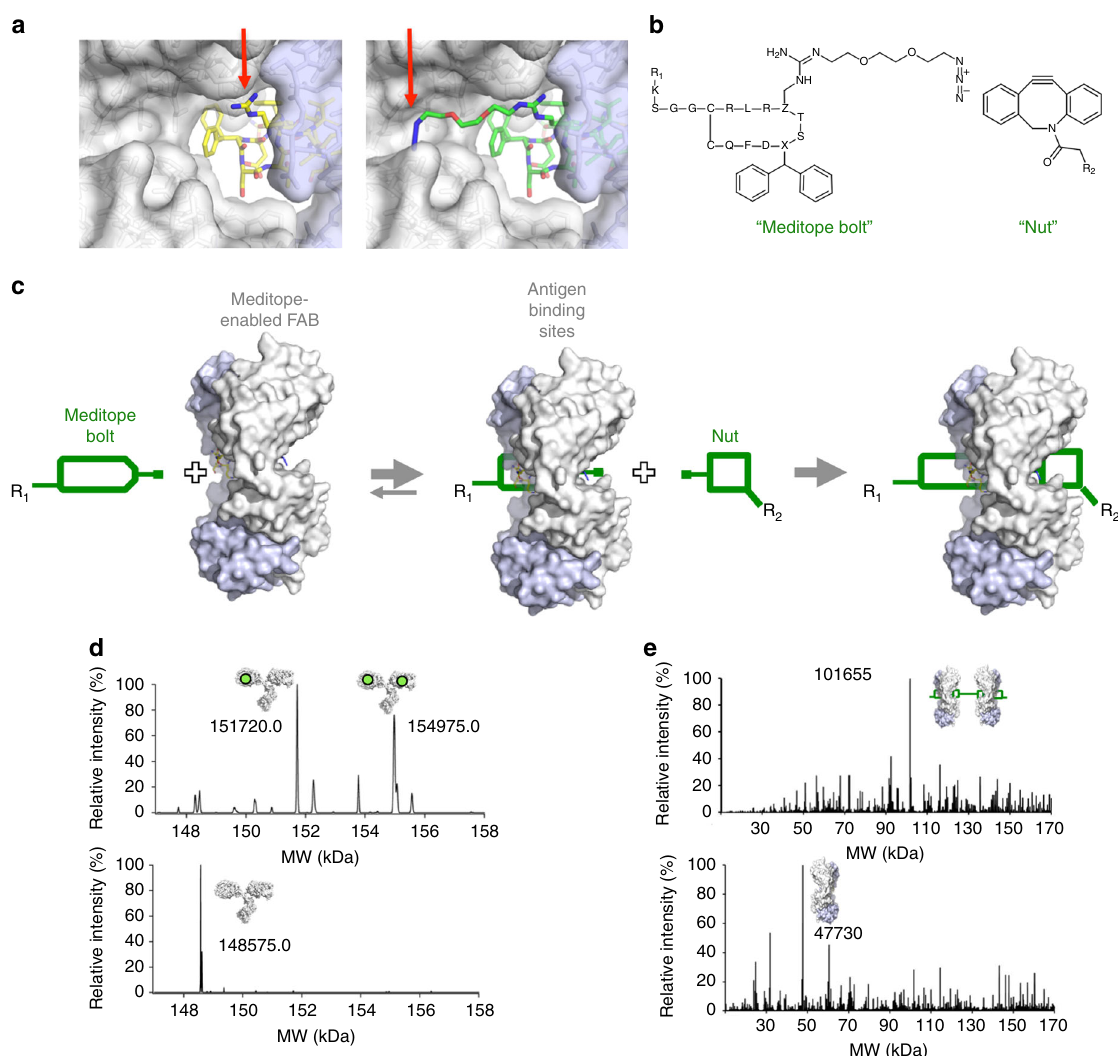
Fig. 2 Development of a mechanical bond to interlock the meditope to a Fab. a Back view of Ile83Glu anti-HER2 antibody Fab with (Ac)CQFDA (Ph) 2 STRRLKC meditope (left) and 5-diphenylalanine-8-Arg-(PEG) 2 -azido-meditope (right). Light blue surface is the light chain; white surface is the heavy chain. The red arrows indicate the modi fi ed residue (arginine 8, left panel) and the reactive azide (right panel). b Chemical structures of the meditope bolt (meditope-containing reactive group) and nut (reactive steric group), the sequence is represented by single letter amino acid code where X represents 5- diphenylalanine and Z represents the modi fi ed azido-arginine. R1 and R2 represent potential modi fi cation sites. c Proposed scheme for forming a mechanical bond. After binding of the azido-meditope, the reactive azide on the backside of the Fab can react with a reactive cycloalkyne to form a mechanical bond. d Native mass spectrometry analysis of the mechanically interlocked meditope – AF647/Ile83Glu anti-HER2 memAb. The difference in molecular weight (3145 and 6400 Da) corresponds to 1:1 or 2:1 complex of mechanically interlocked meditope:IgG (top panel). The spectrum for unlabeled IgG is shown in the bottom panel. The experimentally determined mass of meditope – DIBO – AF647 is 3293.3 Da (see Supplementary Fig. 4). e Mass spectrometry analysis of “ molecular dumbbell ” . Top panel: mass spectrum of puri fi ed reaction product; calculated mass: 101,634 (2×47730 + 2×2178 + 1818), observed mass: 101,655. Bottom panel: mass spectrum of the Ile83Glu, meditope-enabled Fab used for the reaction above; calculated mass: